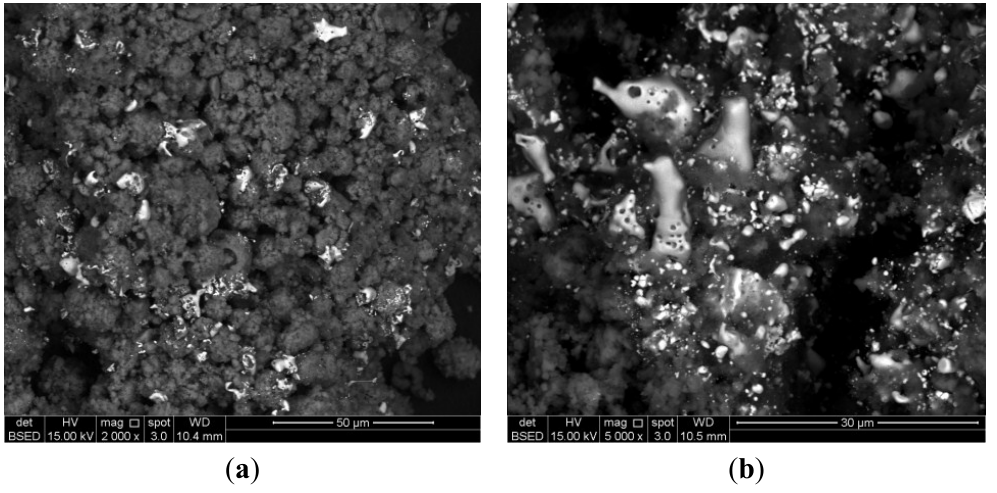
Figure 5. SEM images of the 7.8 wt% Cu-PS sample after H 2 -TPR analysis at magnifications of ( a ) 2000×; ( b )